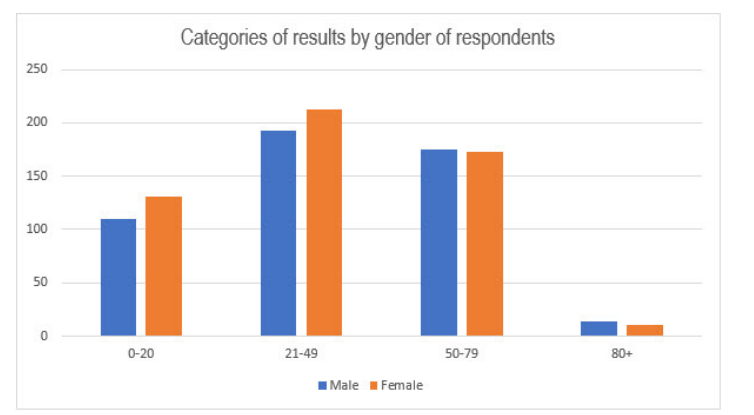
Figure 3. Distribution of result categories by gender of